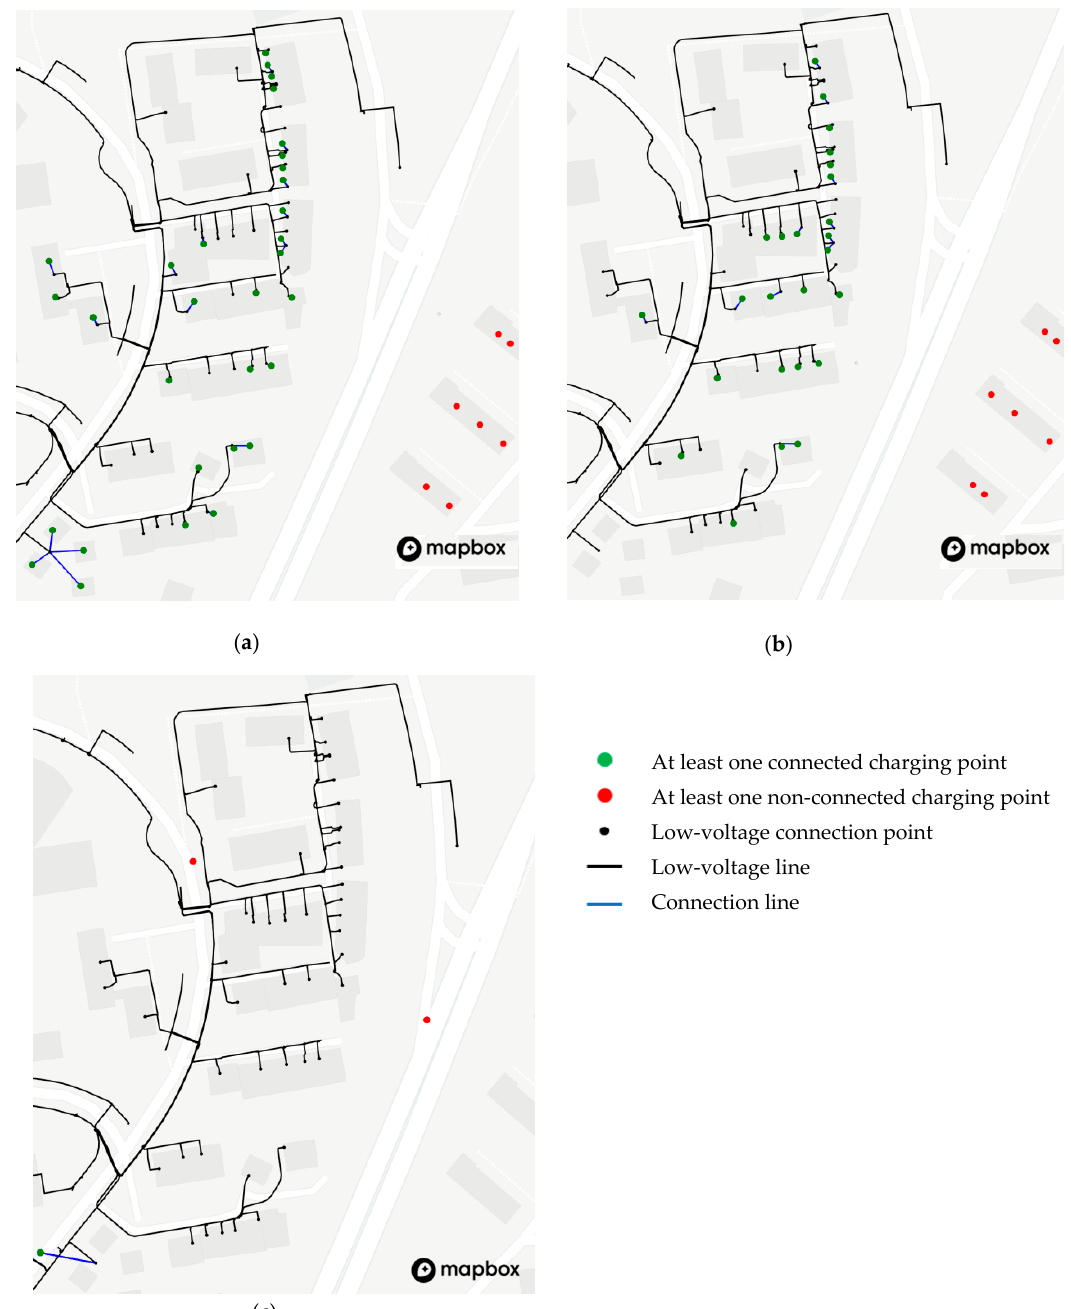
Figure 9. 1 of 50 charging point allocation variants ( a ) at household level considering household attributes, ( b ) at household level ignoring household attributes and ( c ) at street level considering household attributes. Prints use map data from Mapbox and OpenStreetMap and their data sources. To learn more, visit https: // www.mapbox.com / about / maps / and http: // www.openstreetmap.org /